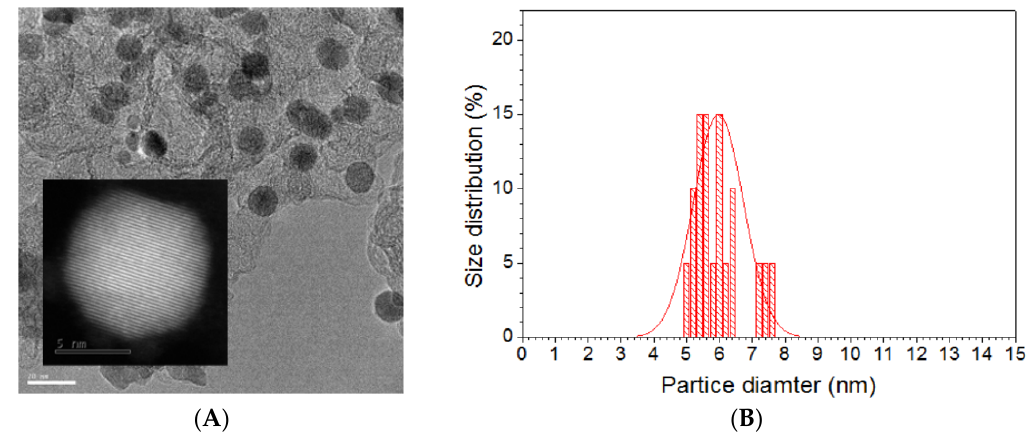
Figure 3. A representative set of TEM and high ‐ resolution TEM (HRTEM) image ( A ); and size distribution ( B ) for a sample of Pd 21 Cu 79 nanoparticles. Note that the scale bars are 20 nm and 5 nm for the TEM and the inserted HRTEM images, respectively.